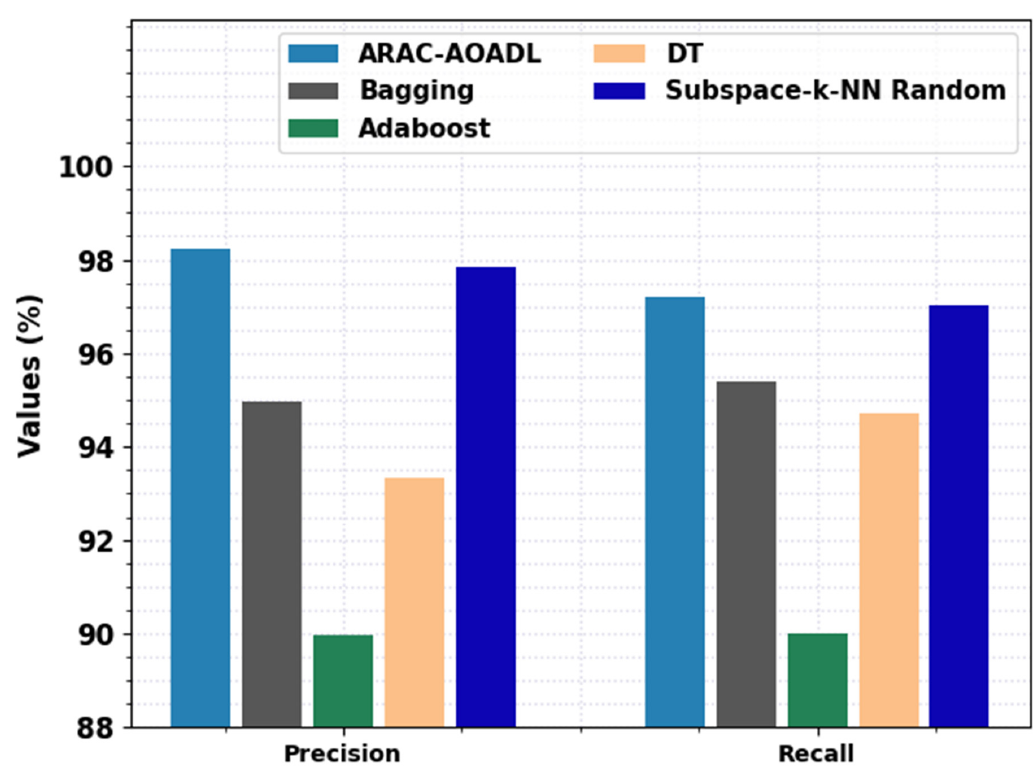
Figure 7. Comparative RA Classification results of ARAC-AOADL model interms of prec n and reca l .